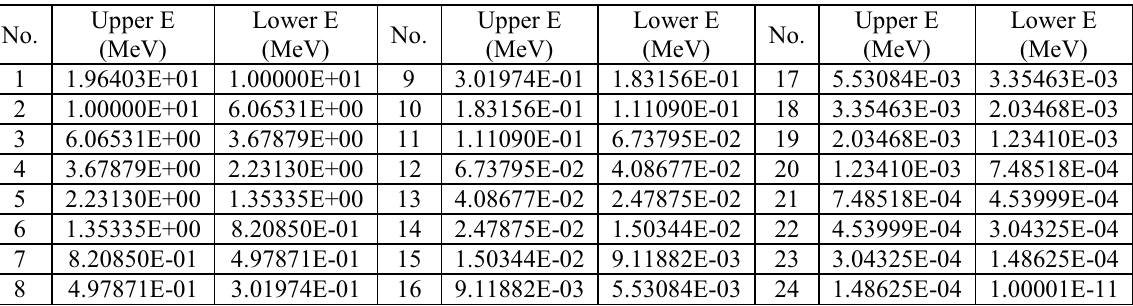
Table II. 24-group energy